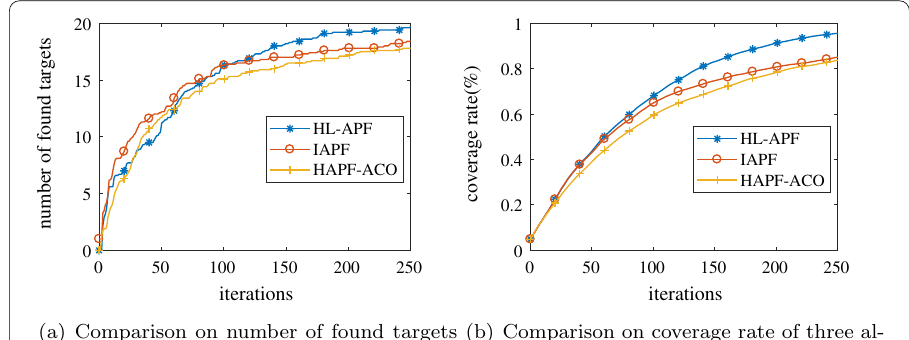
Fig. 5 Comparison after 250 iterations for the mission of three algorithms